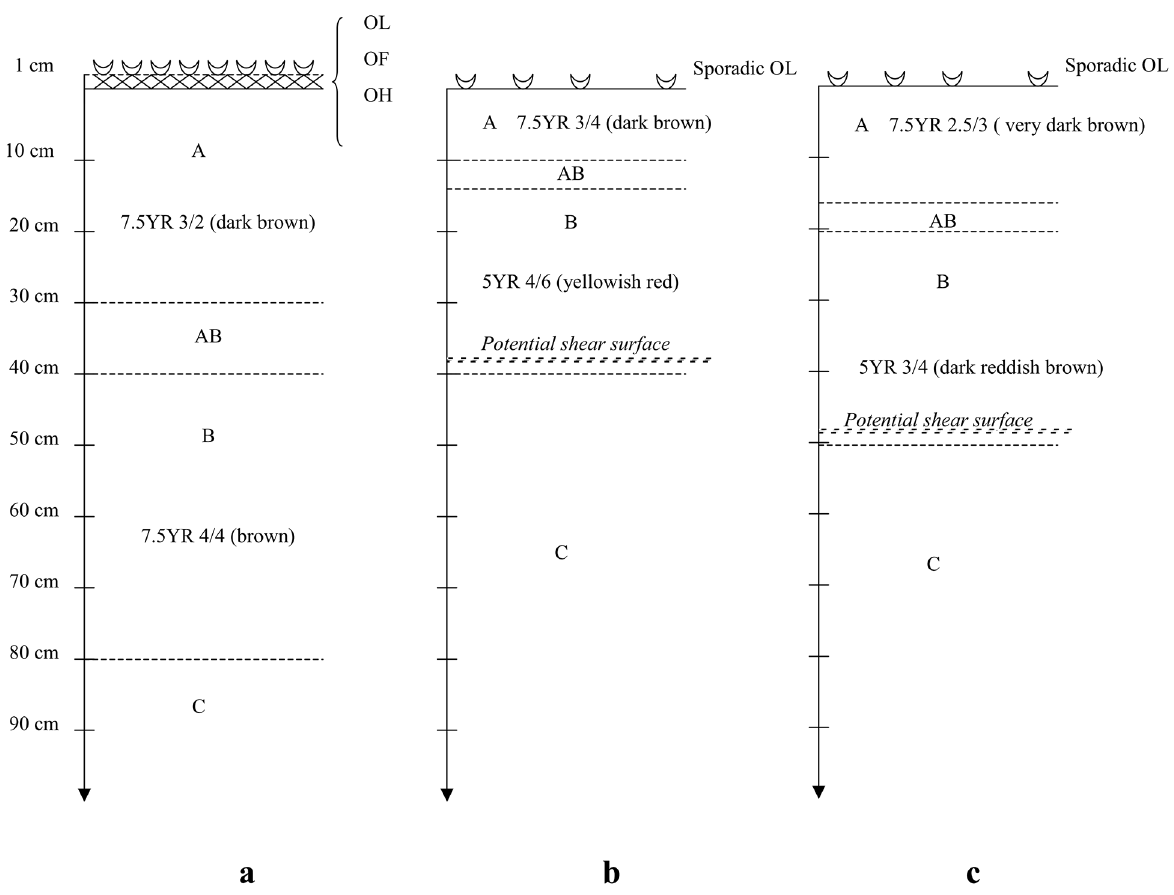
Figure 2. Soil profiles at the study site. Soil horizons at a) a reference site with no previous evidence of landslides or erosion; b) the stable site where a shallow landslide had occurred eight years previously and c) the hotspot. Colours were identified using a Munsell colour chart (Munsell 1947). OL: fresh litter, OF: fermenting litter, OH: litter with humic substances and well-transformed organic matter, A: organico-mineral layer, AB: mixture between A and B, B: layer of bedrock alteration, pieces of bedrock are visible, C: bedrock, mineral layer (Legros 2000; Baize and Girard